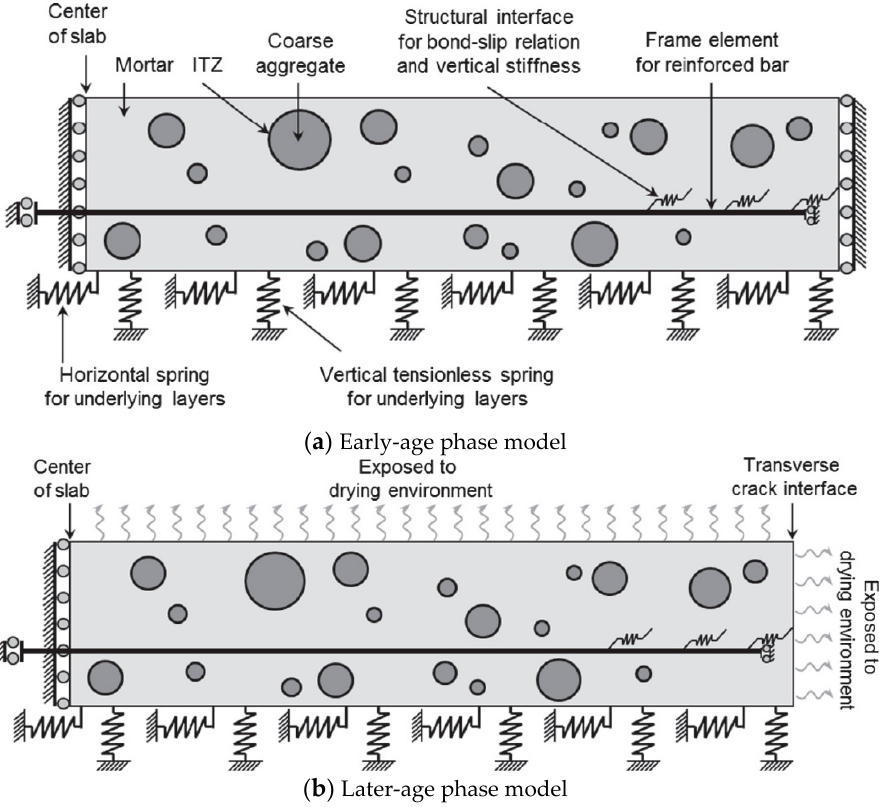
Figure 4. Early ‐ age and Later ‐ age phase model [29]. Figure 4. Early-age and Later-age phase model